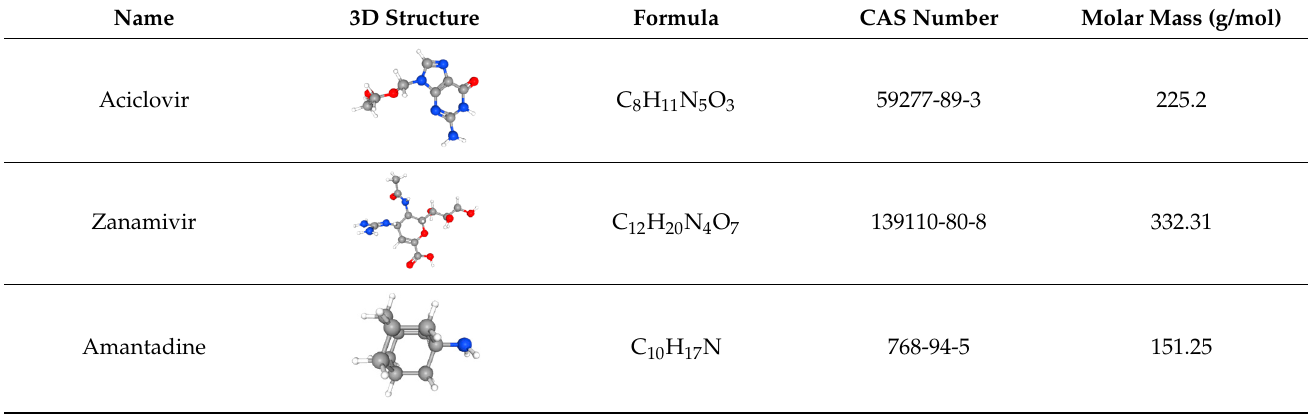
Table 1. Recommended antiviral drugs during the epidemic [23].